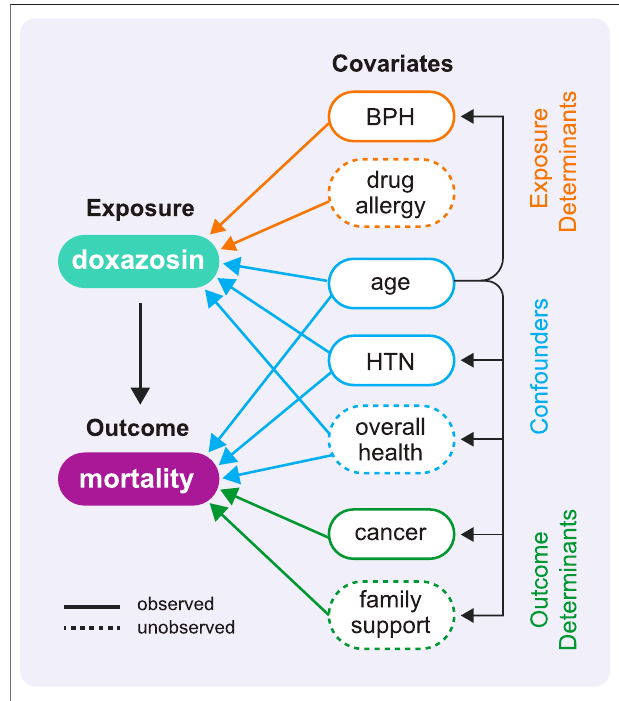
FIGURE 2 | This directed acyclic graph (DAG) shows the types of variable relationships described in Rule 3 using the example COVID-19 study. A DAG has no cycles, which means no variable can cause itself, either directly or through one or more other variables. In our effort to estimate the causal effect of doxazosin on mortality, this DAG helps us identify which variables will be important to adjust for in our analyses (in reality, this diagram would include many more variables of these same types). It is the set of confounders that has the ability to distort the association between exposure and outcomeasrevealedbythearrowsleadingfromeachconfoundertoboth the exposure and the outcome. We highlight two observed confounders: the demographic confounder age and the comorbidity confounder hypertension (HTN). We also depict the unobserved confounder overall health, which we might attempt to measure using indicators of overall health like frequency and duration of recent inpatient